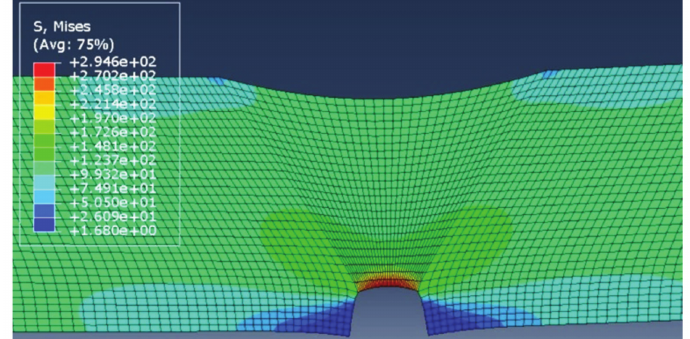
Figure 8. Results for vertical misalignment, incomplete root penetration, and undercut.